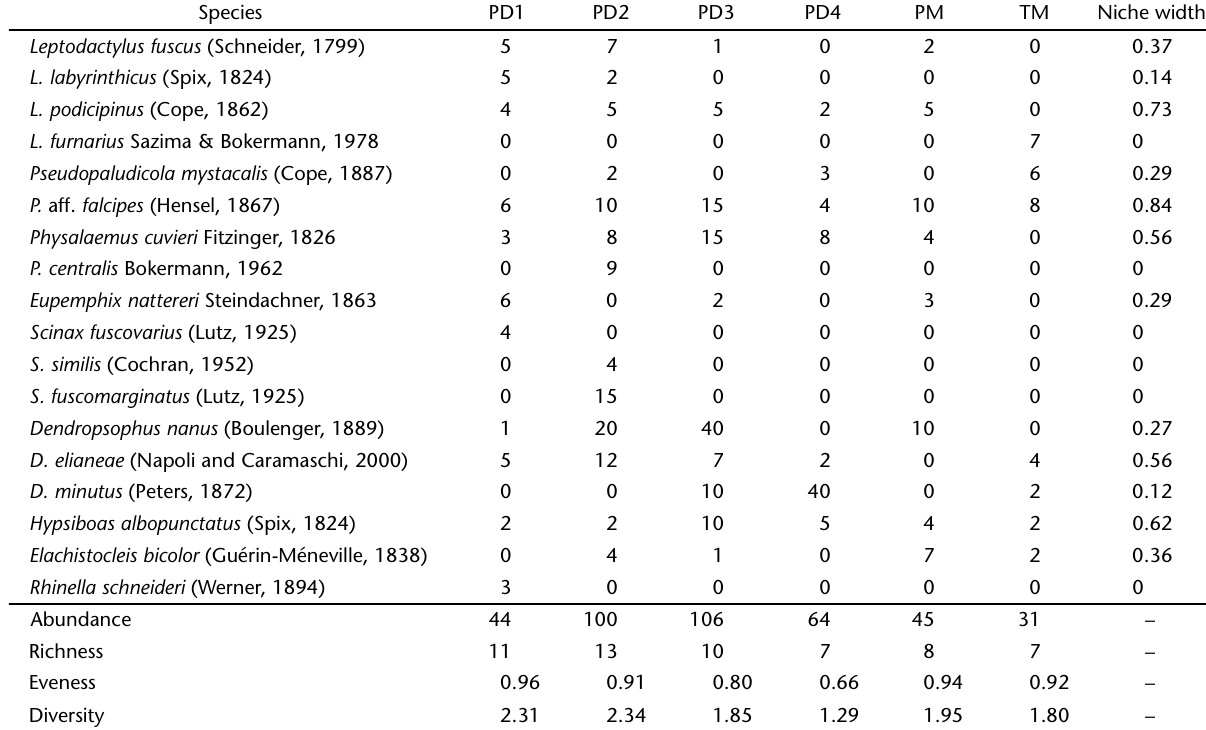
Table II. Abundance, richness, evenness, diversity, and niche width (Levins index) of species recorded in the six breeding ponds sampled between September 2004 and August 2005 in Icém, São Paulo.